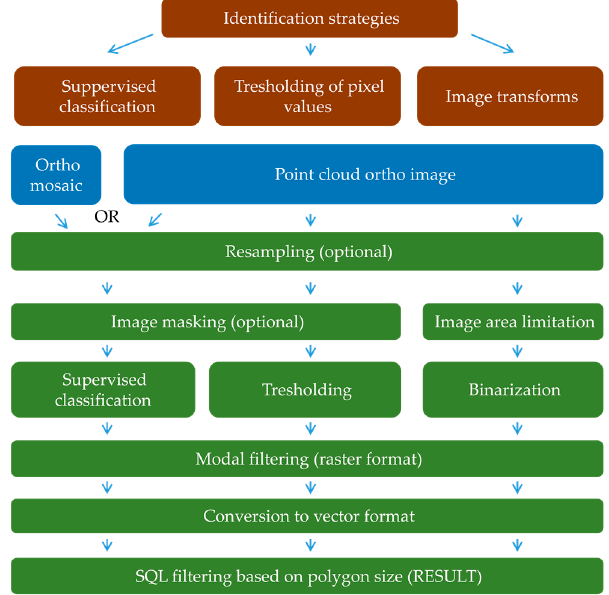
Figure 2. The strategies of water body range identification: blue shows the products suitable for the strategy and green shows the main processing